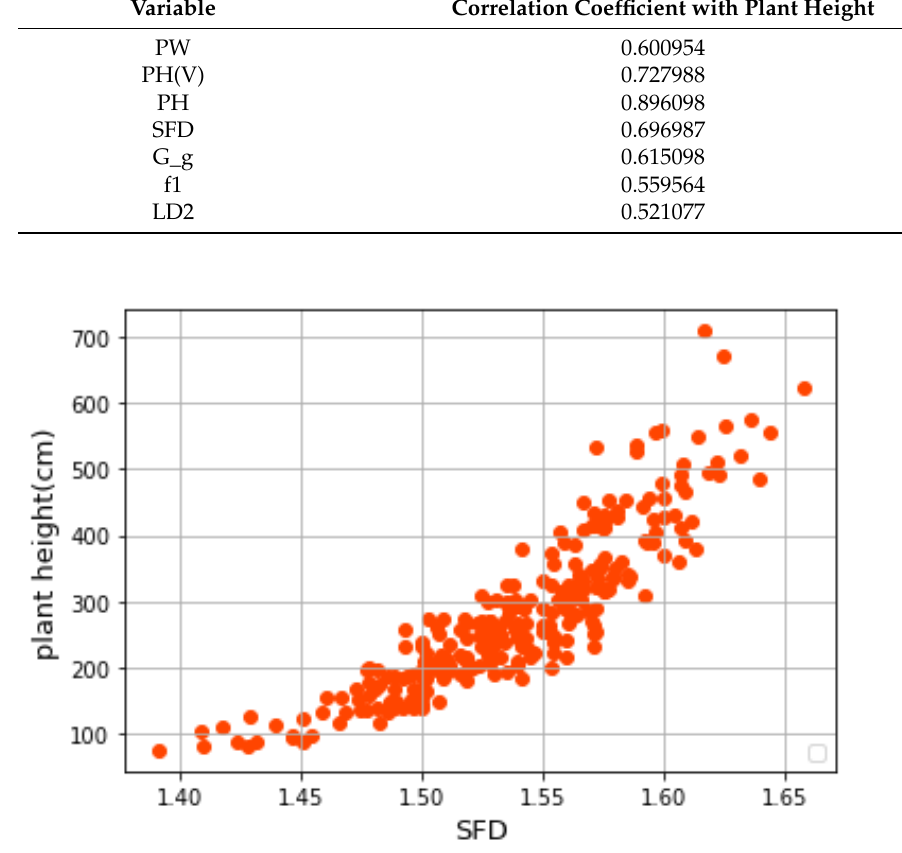
Figure 6. Scatter diagram of SFD and plant height.